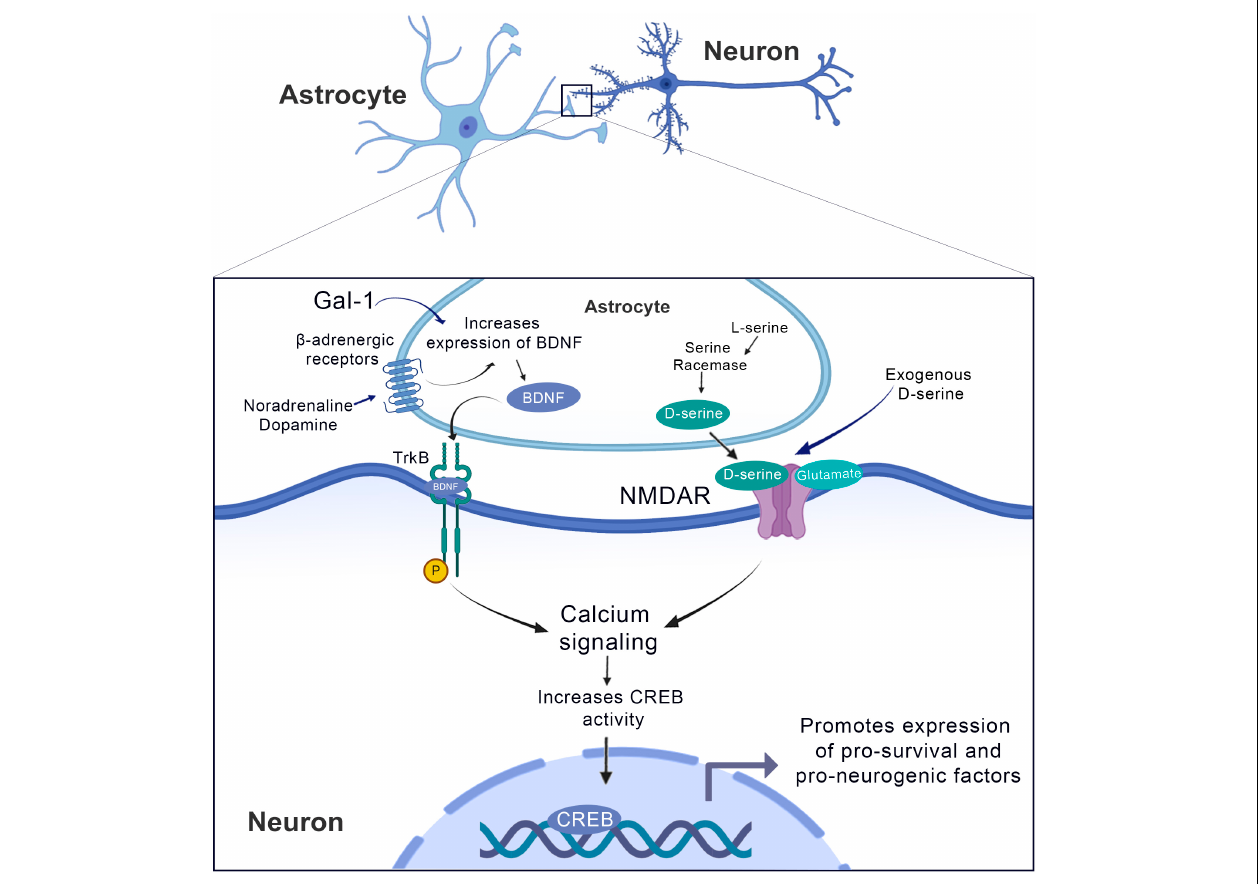
FIGURE 5 | The brain-derived neurotrophic factor (BDNF) supports neurogenesis in normally non-neurogenic brain regions. Gal-1 treatment induces the production of BDNF from cortical astrocytes from this increase in BDNF, an activation of the TrkB receptor occurs, which in turn increases calcium signaling and CREB activity, promoting the expression of pro-survival and pro-neurogenesis factors. Similarly, we observed the effect of noradrenaline and dopamine by increasing the BDNF and following the cascade downstream. In turn, the effect of D -serine is on NDMA receptors, increasing the intracellular calcium signaling favoring the increase of CREB